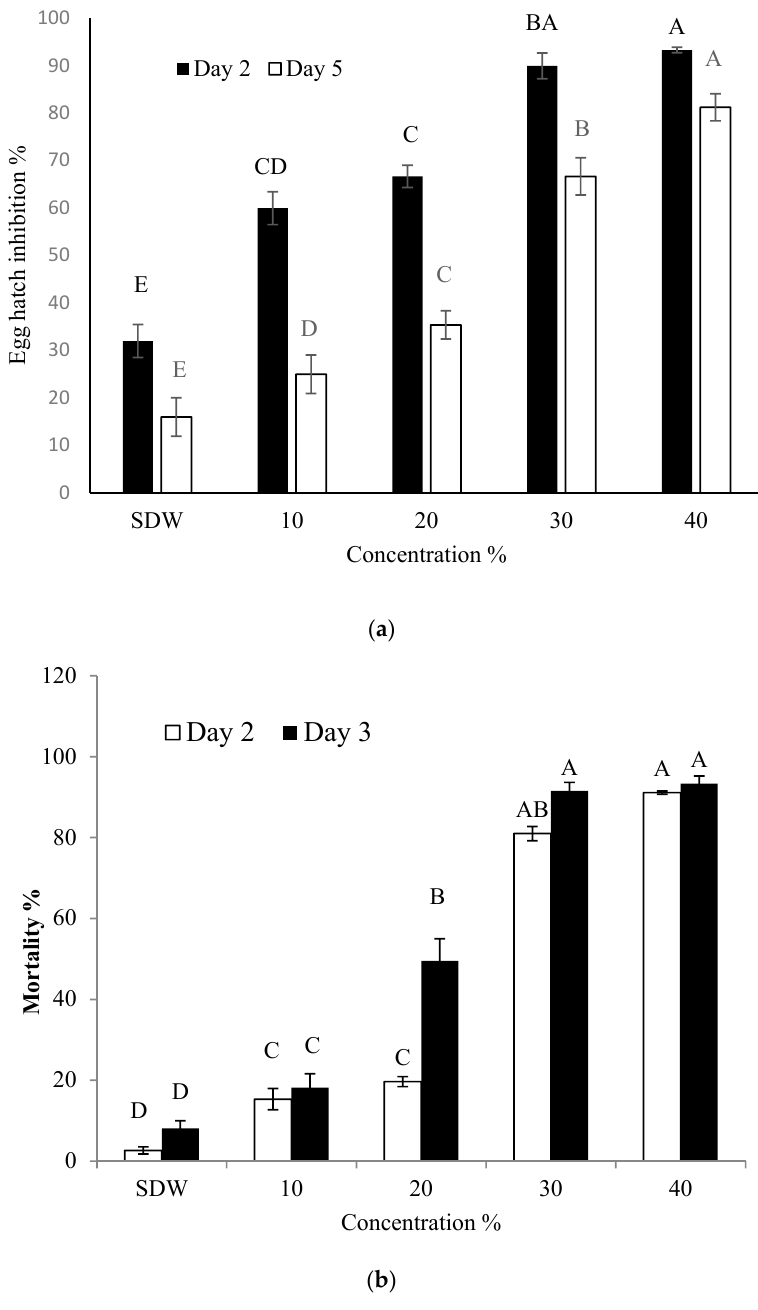
Figure 1. Effect of different concentrations of culture supernatant of strain Y1 on egg hatching ( a ) and mortality ( b ) of M. incognita at 26 °C for 2 and 5 days (eggs) and 1 and 3 days (J2) incubation. Serial distill water (SDW) was used as control. Error bars represent standard error of the mean from three replicates. Means with the same letter in same observation time are not significantly different at p ≤ 0.05 when compared with LSD.